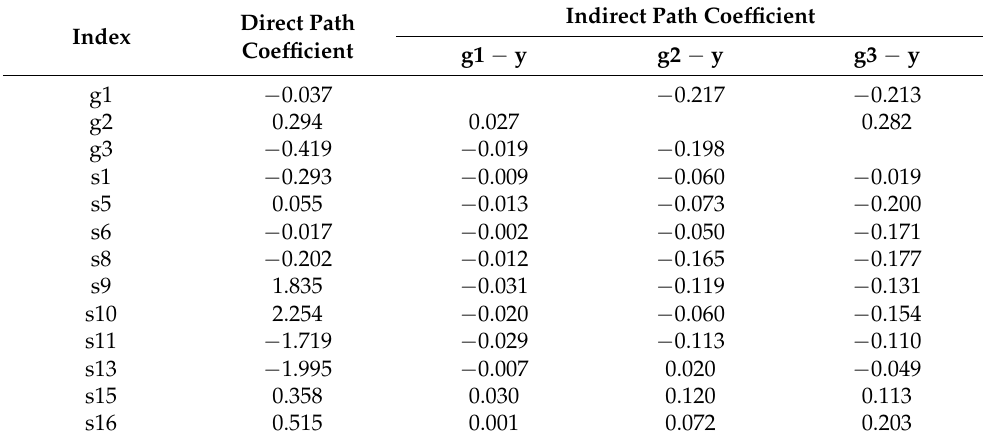
Table 9. Path analysis of meteorological factors, grain nutritional quality, and the 100-grain weight.